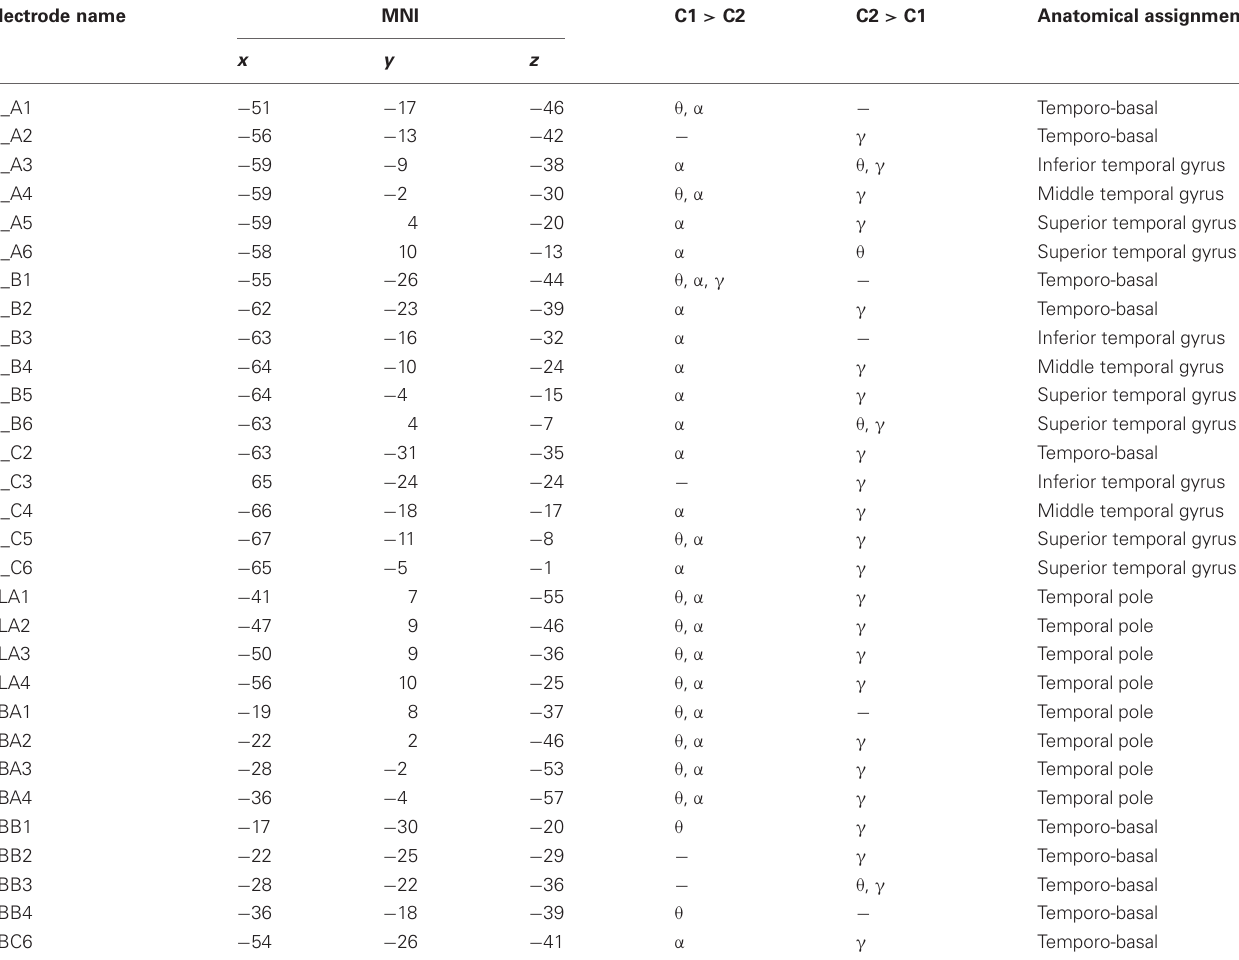
Table 3 | Statistically significant effects ( p < 0 . 001, FDR) in the theta ( θ ), alpha ( α ), and gamma ( γ ) frequency bands, MNI coordinates, and anatomical locations of ATL electrodes in